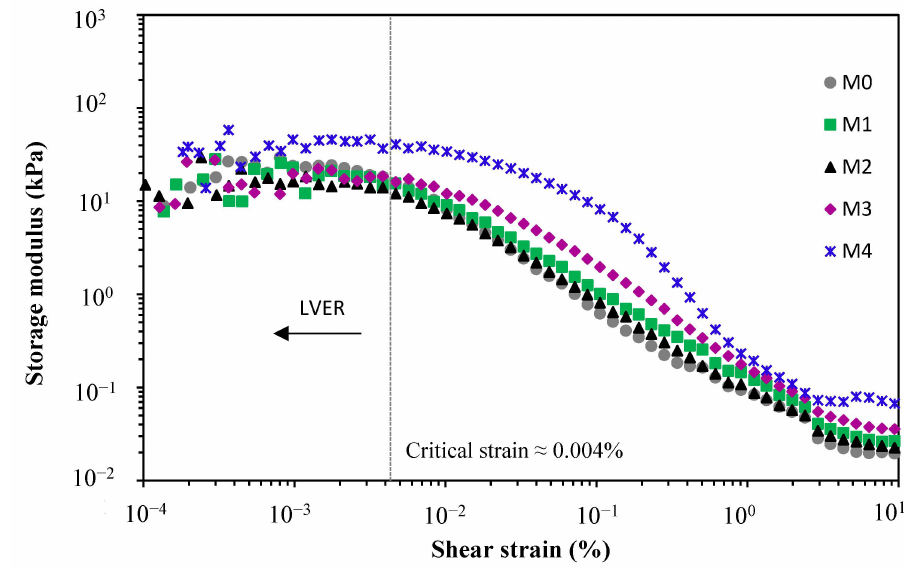
Figure 4. Strain sweep test results showing LVER of the